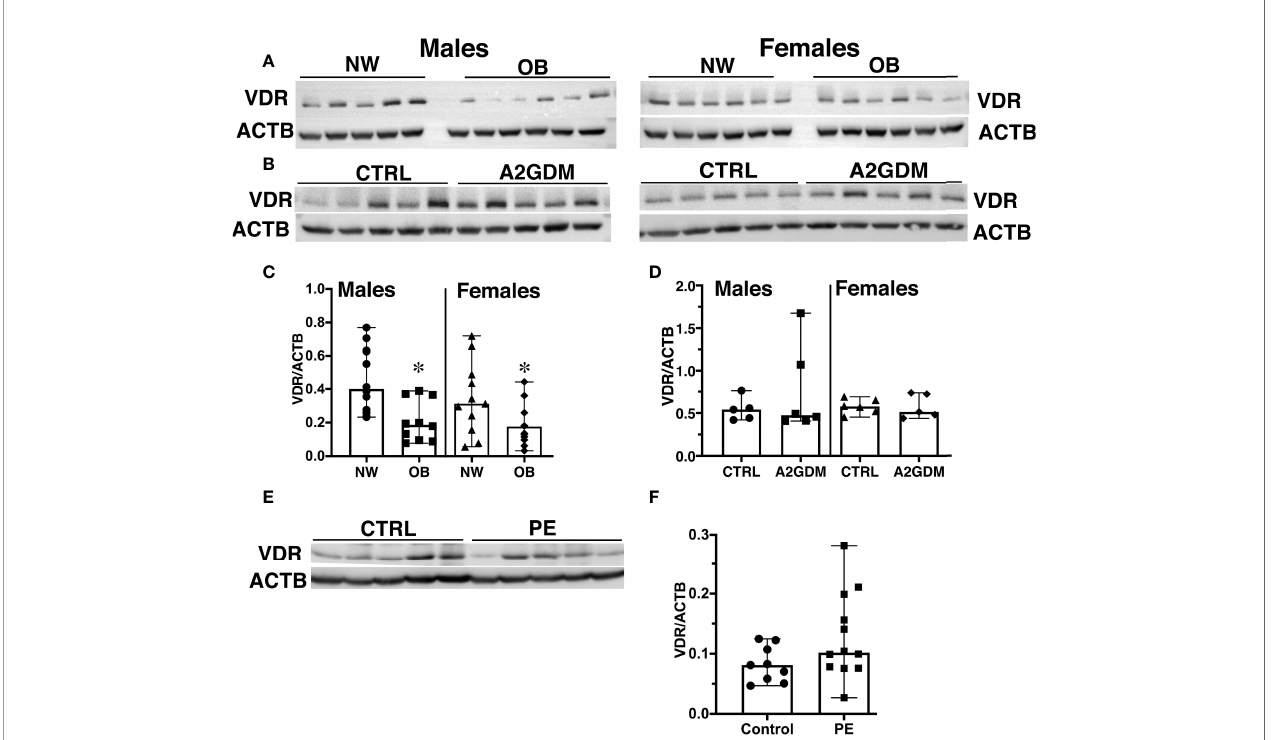
FIGURE 2 | Effect of maternal obesity, gestational diabetes, and preeclampsia on placental expression of Vitamin D receptor (VDR). (A, C), Representative images (A) and quanti fi cation (C) by Western blot of VDR in placentae from normal-weight and obese women with male and female fetuses. (B, D) , Representative images (B) and quanti fi cation (D) by Western blot of VDR in placentae from pregnancies complicated by gestational diabetes regulated by insulin (A2GDM). (E, F) , Representative images (E) and quanti fi cation (F) by Western blot of VDR in placentae from pregnancies complicated by preeclampsia (PE). Control samples for A2GDM and PE were matched by BMI. Data were normalized to b -actin; values are mean ± SEM.*, p <0.05. Sample sizes are given in Table 1 and Supplemental Tables 1, 2